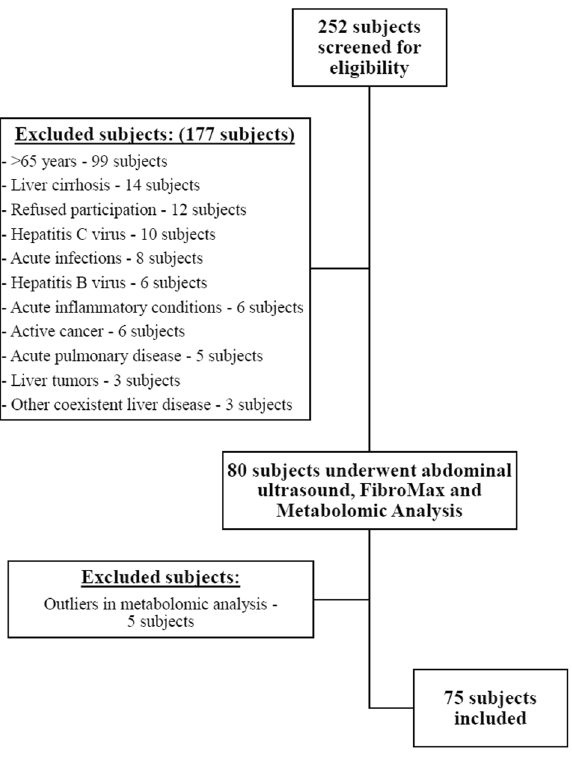
Fig. 1 Flow diagram of included and excluded